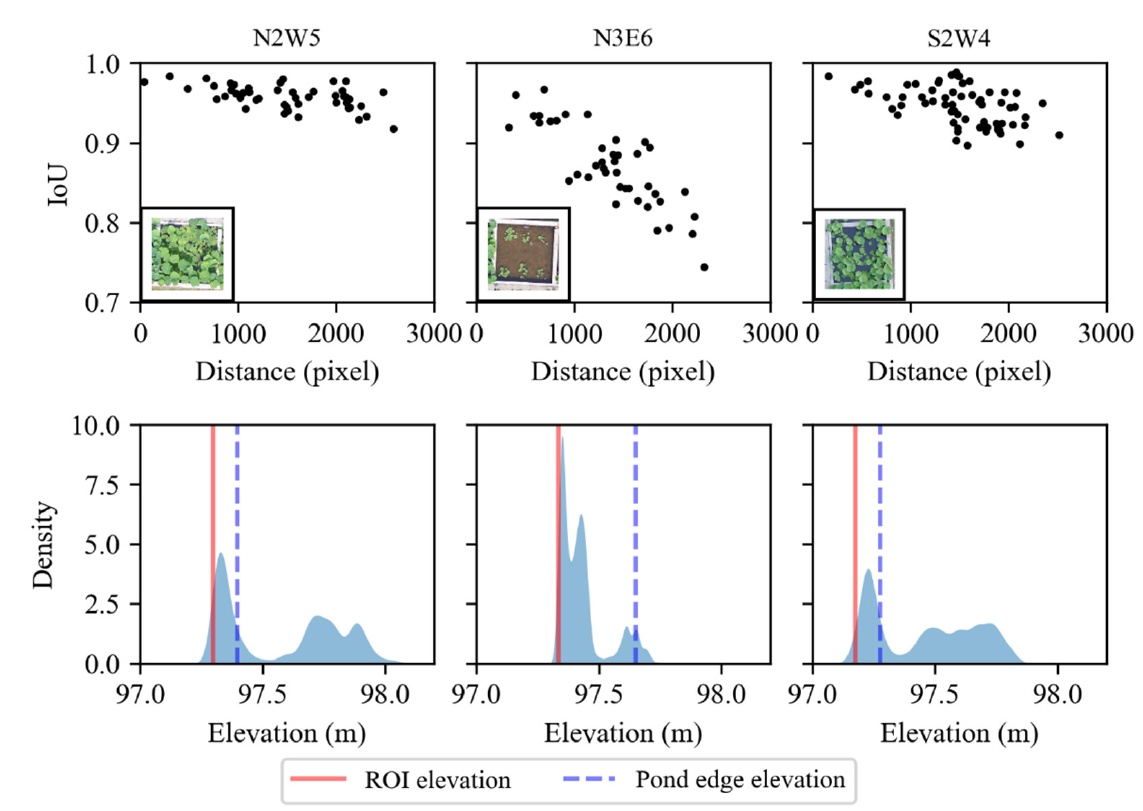
Figure 5. Transformation accuracy examination results. Three plots with different lotus leaf densities and heights were selected. All the expected ROI transformation positions were marked manually on raw images using LabelMe annotation software. The distance is the Euclidean pixel distance from the reversed region of interest (ROI) center to the photo center. The distribution of each pixel point height is shown in the blue area, the height of the ROI (solid red lines) is the mean value of all the pixel points smaller than the 5th percentile threshold, and the height of the plot edge (blue broken lines) is the mean value of random 10 points picked from QGIS on the DSM.